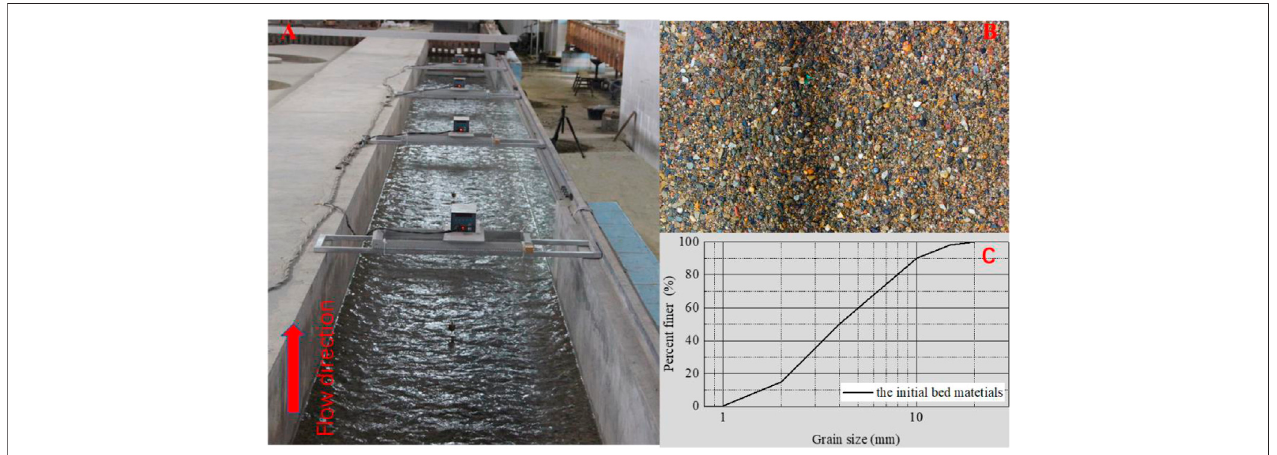
FIGURE 1 | Experimental fl ume and initial bed surface (A) Photograph of fl ume during experimental procedure, (B) photograph of initial bed materials (width: 20 cm), and (C) bed size distribution curve of initial bed materials.